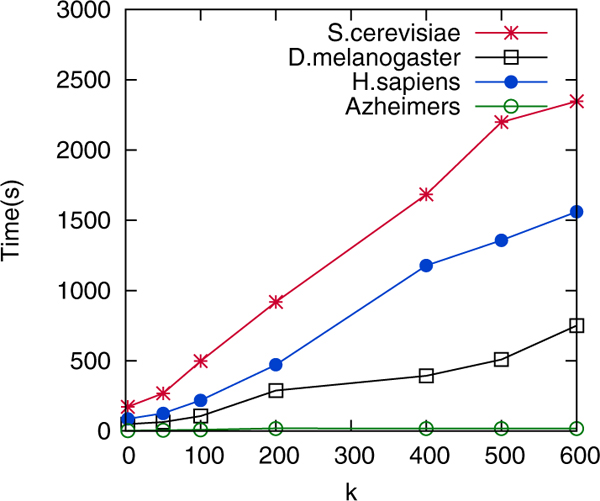
Running times of FUSE (in sec.).